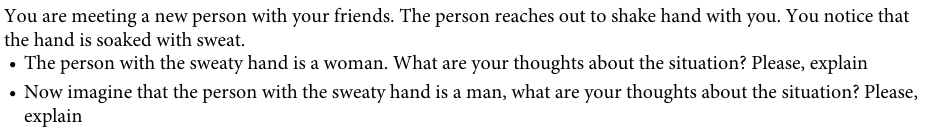
Table 2. Example of a vignette used during